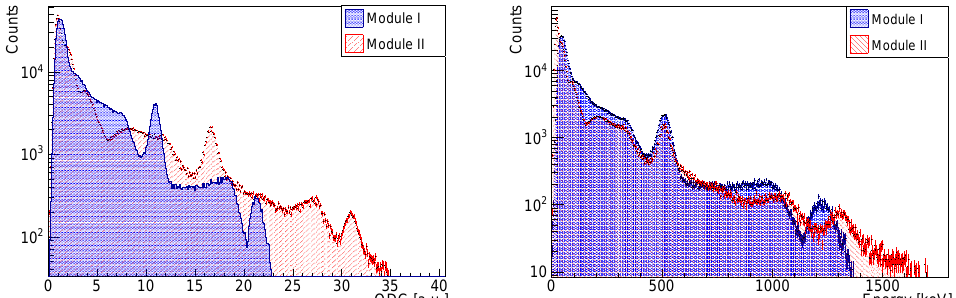
Figure 2. The 22 Na spectra before non-linearity correction and calibation measured by a crystal from Module I and Module II at V OV = 3 V, respectively ( left ). The energy spectra of 22 Na after applying the non-linearity correction and calibration of the 511 keV peak ( right